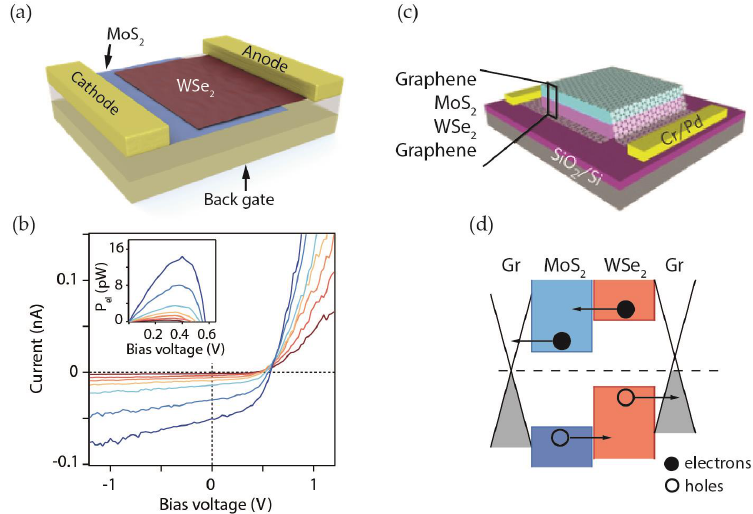
Figure 8. Photovoltaic cells. ( a ) Schematic device layout of a vertical heterojunction device with lateral contacts. A p-n junction is formed at the interface between an n-doped MoS 2 sheet and a p-doped WSe 2 sheet. Reproduced with permission from [36], Copyright Nature Publishing Group, 2014. ( b ) Electrical (main panel) and optical (inset) characteristics of the solar cell. The incident laser power is increased from 180 W/m 2 (red curve) to 6400 W/m 2 (blue curve). Reproduced with permission from [36]. ( c ) Schematic device layout of a vertical heterojunction with graphene electrodes on bottom and top, which allow for vertical carrier extraction. Reproduced with permission from [37], Copyright Nature Publishing Group, 2014. ( d ) Schematic of the bandstructure. The horizontal arrows indicate exciton dissociation and charge carrier diffusion. Reproduced with permission from